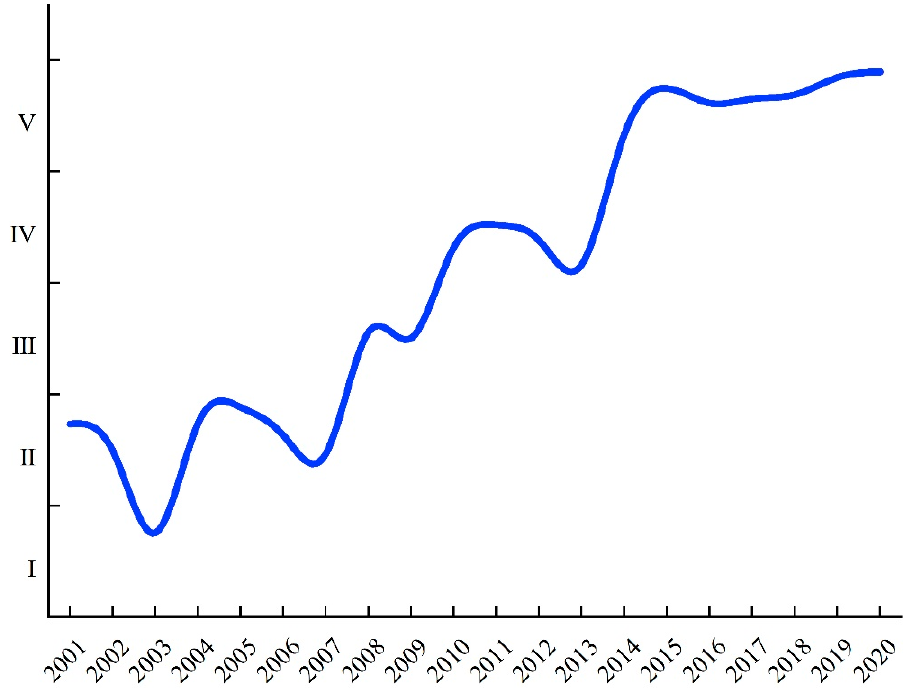
Figure 1. Trend map of China’s food security grades from 2001 to 2020.